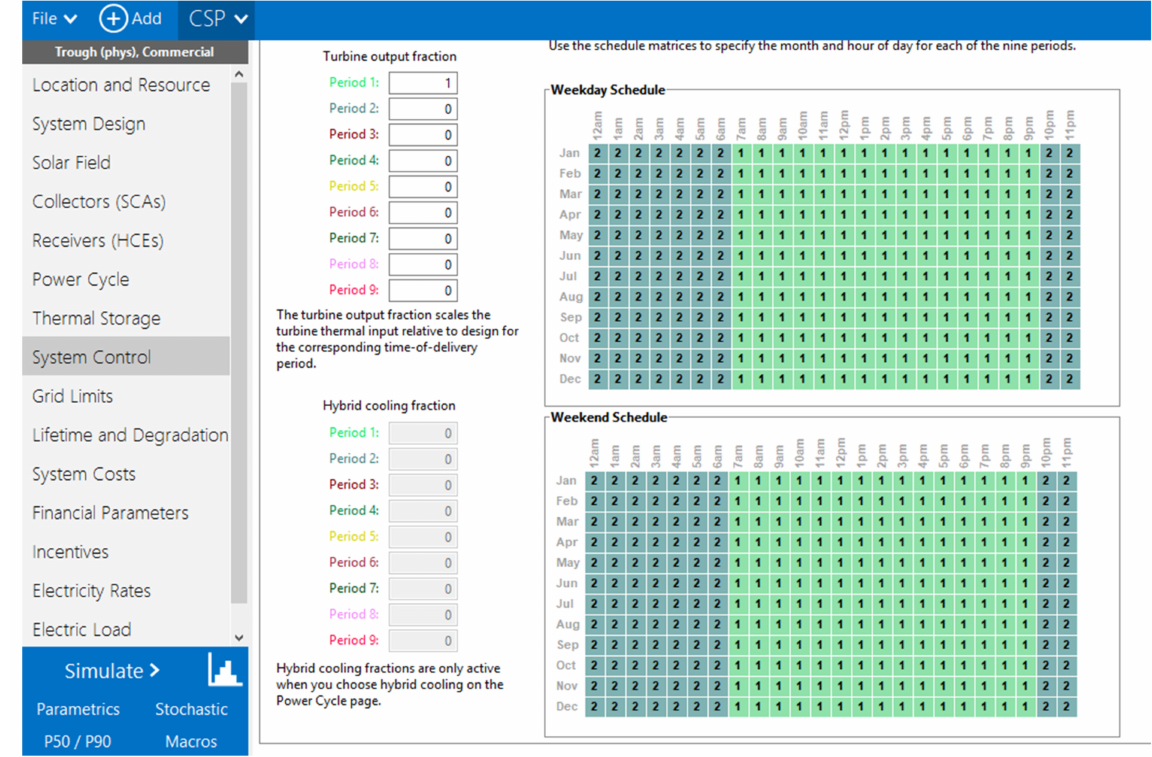
Figure 7. Dispatch control for CSP and TES in